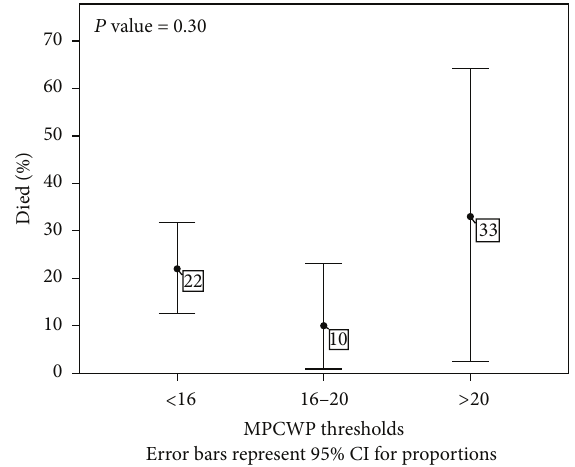
Figure 3: The error bars plot shows that the rate of death does not significantly vary with different mean capillary wedge pressures (MPCWPs)